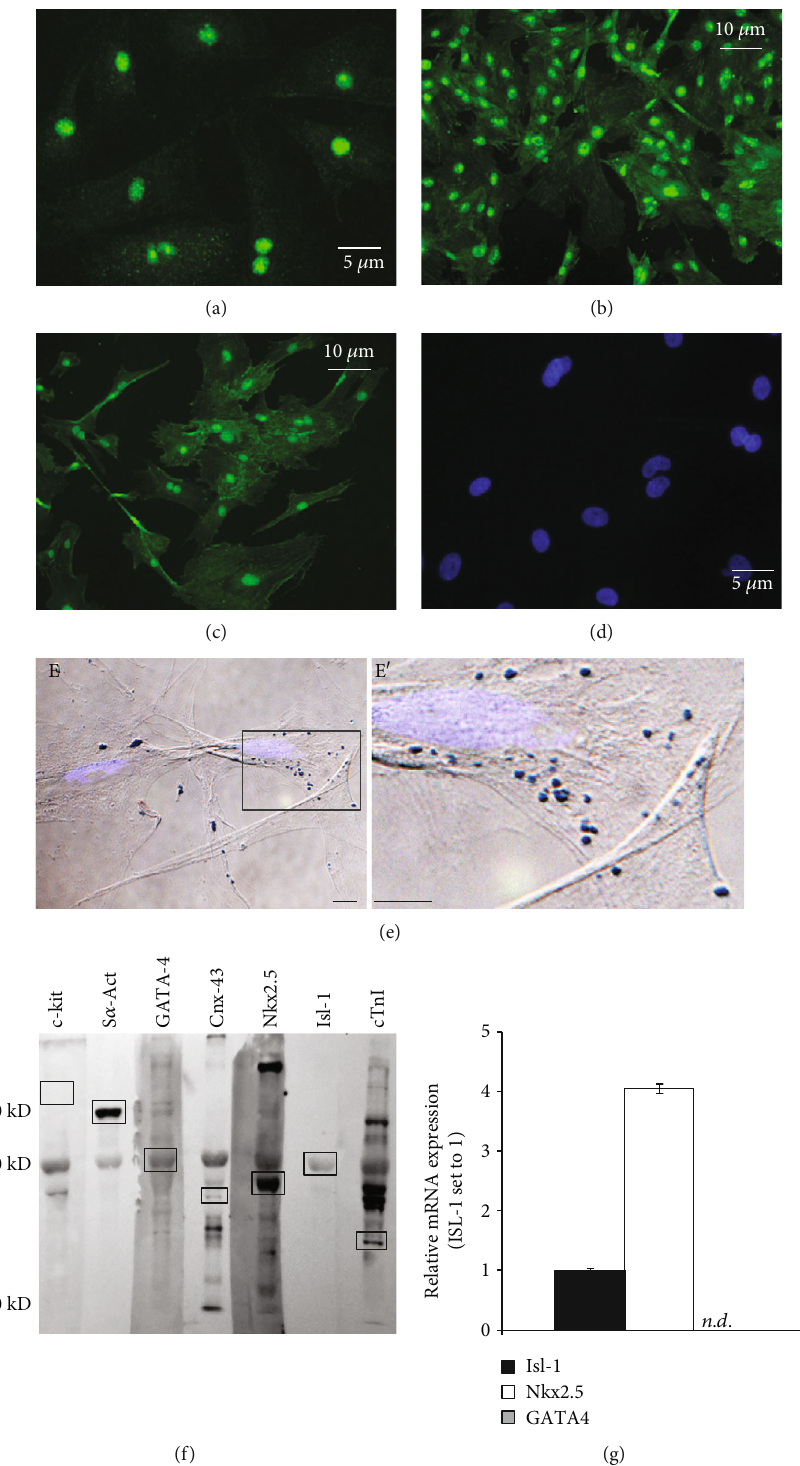
Figure 1: Characterization of isolated embryonic cardiac stem cells in culture. (a) – (c) Immuno fl uorescence micrographs showing cells isolated from E12.5 rat hearts expressing various cardiac progenitor markers: Isl-1 (a), Nkx2.5 (b), and GATA-4 (c). (d) Blank, in which the primary antibody was omitted. (e) Bright fi eld and superimposed fl uorescence micrograph of cells stained with Prussian Blue demonstrate incorporation of MION in the cytoplasm A close-up view of (e) is shown (e ’ ). Light blue: nuclei (DAPI); dark blue: MION. (f) Western blot analysis of cell extract con fi rmed expression of various cardiac markers (Islet-1, Nkx2.5, GATA-4, sarcomeric α -actinin, cardiac troponin I, connexin-43). Cells were identi fi ed as c-kit - .(g) Real-time PCR analysis showed that, after several passages in culture, isolated cells lost expression of